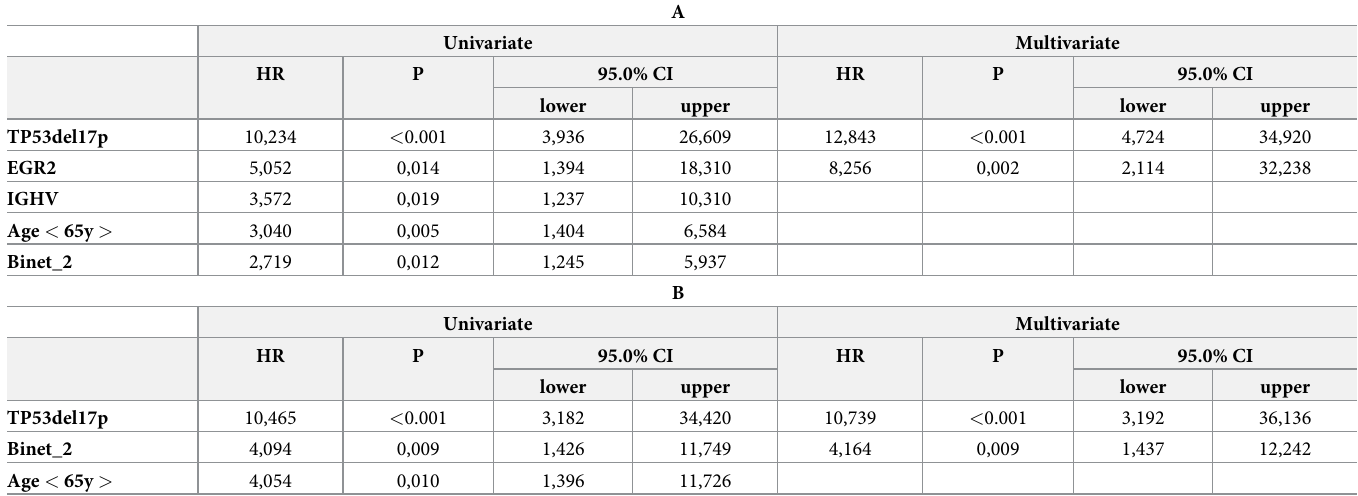
Table 2. Univariate and multivariate analysis. A. Progression-free survival B. Overall